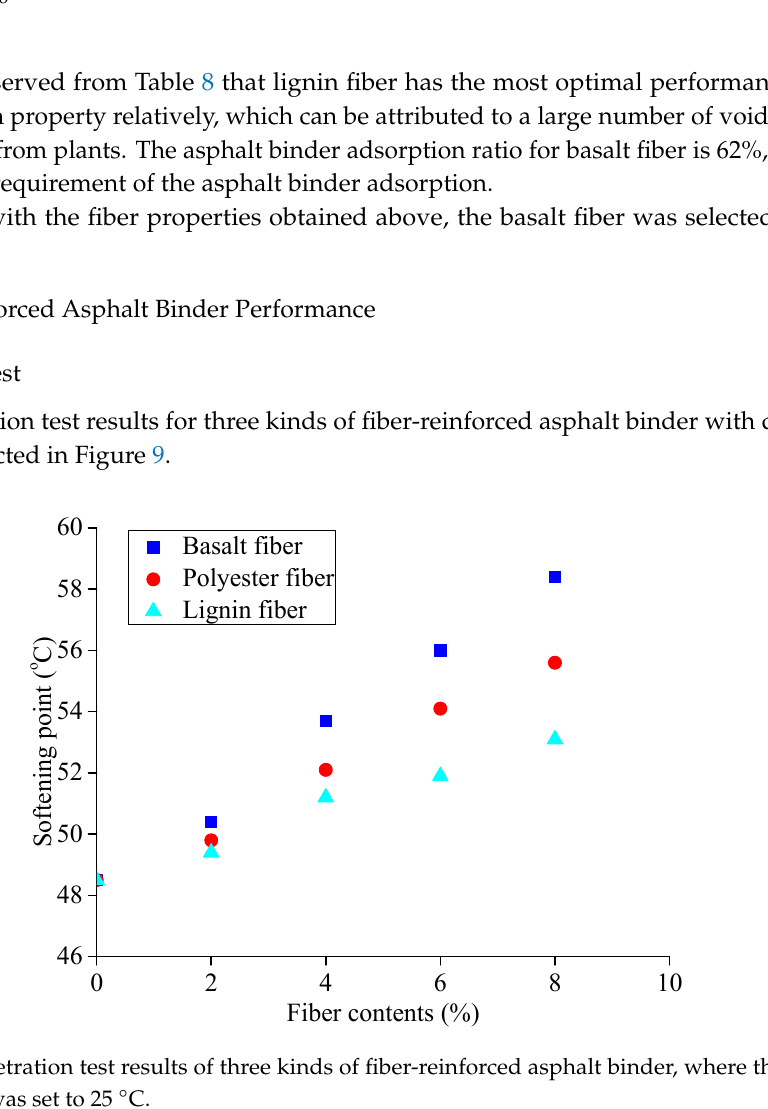
Figure 9. Penetration test results of three kinds of fiber-reinforced asphalt binder, where the testing temperature was set to 25 °C.